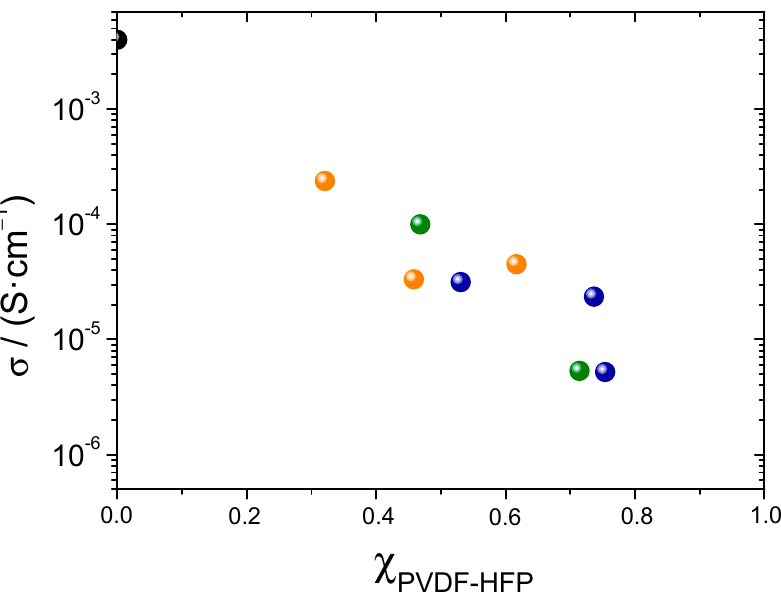
Figure 6. σ as a fraction of the molar fraction of PVDF–HFP ( χ PVDF – HFP ) in the electrolyte at 25 °C.